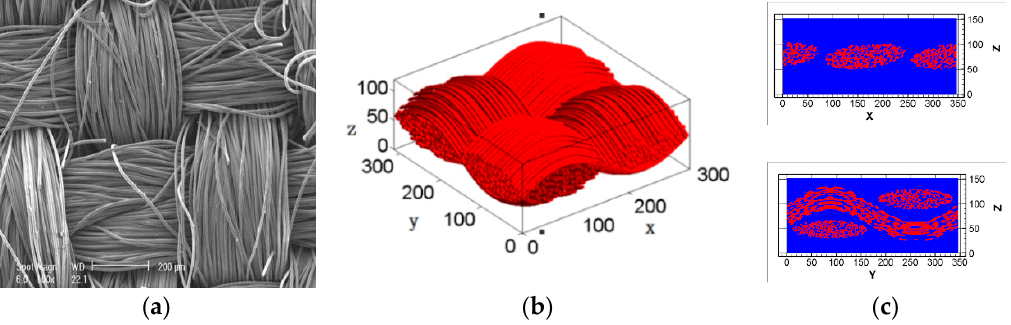
Figure 4. ( a ) SEM image of carbon cloth GDL [25]. ( b ) The single-fiber carbon cloth GDL and ( c ) slices Figure 4. Images of carbon cloth GDL samples. ( a ) SEM image of carbon cloth GDL [25]. ( b ) The of the reconstructed model. single-fiber carbon cloth GDL and ( c ) slices of the reconstructed